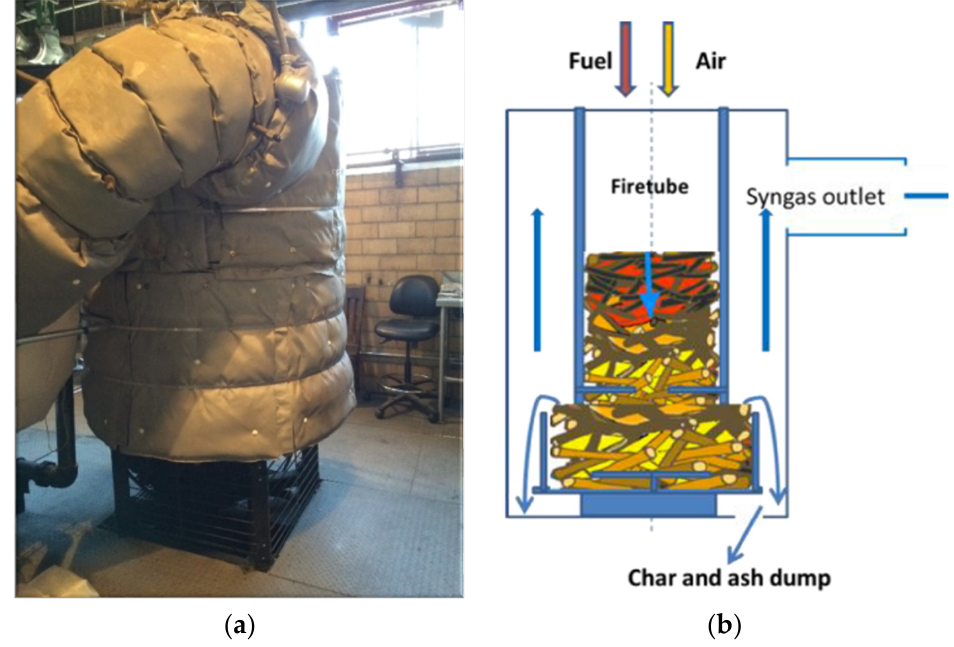
Figure 2. ( a ) Pilot scale single-stage downdraft gasifier; ( b ) Interior schematic of the single stage downdraft gasifier. Table 2. Experimental conditions.